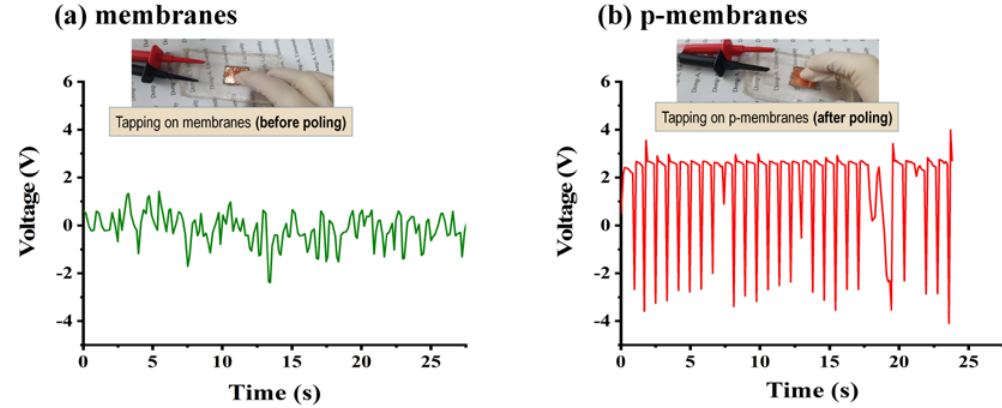
Figure 3. Tapping-mode piezoelectric output voltages of ( a ) membranes and ( b ) p-membranes.